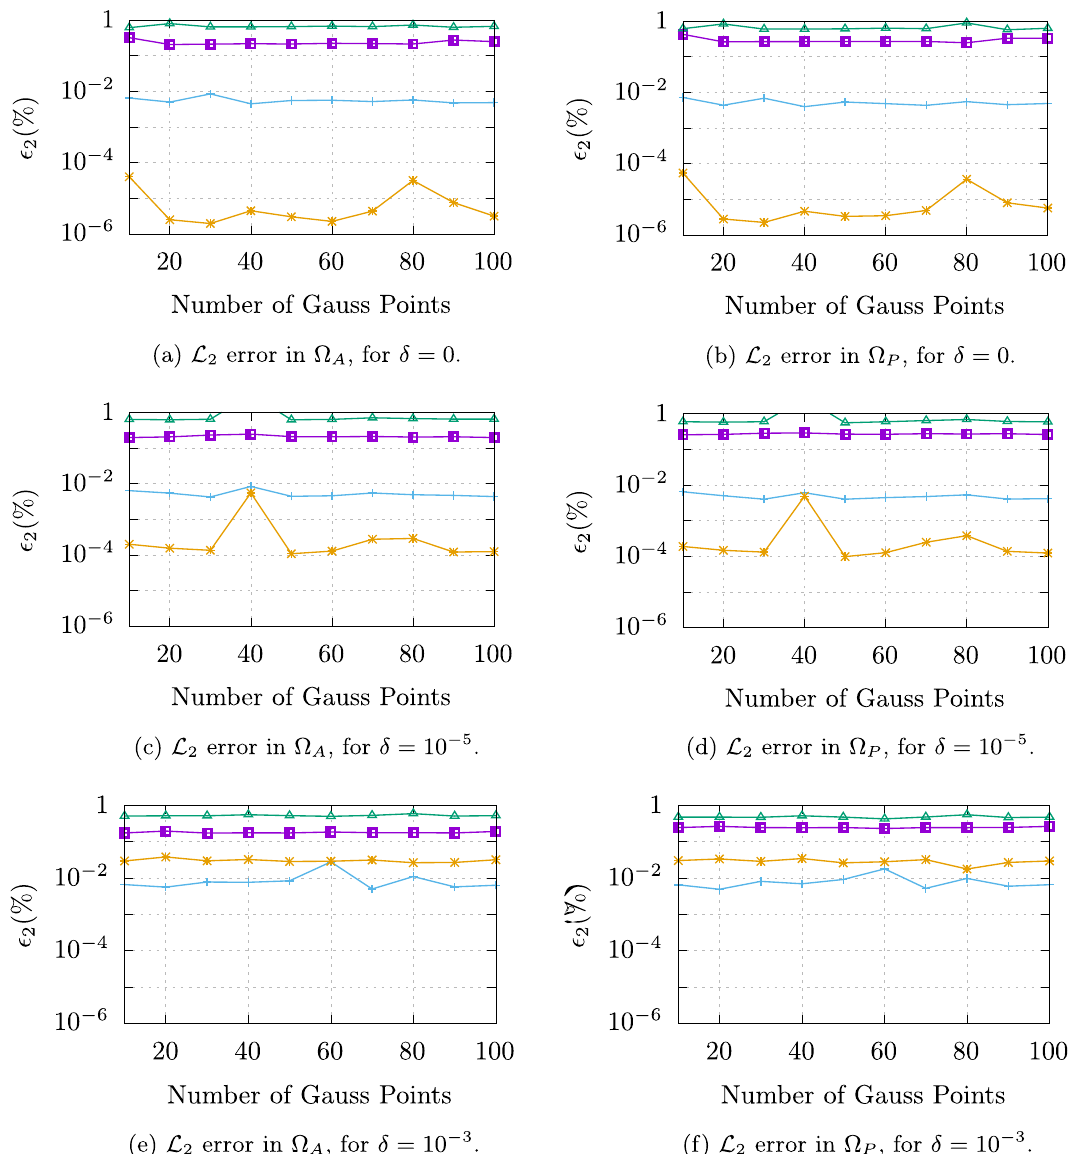
Figure 8. In fl uence of d and the number of Gauss points on the L 2 error at 3500 Hz with C = 12 and different mode order n